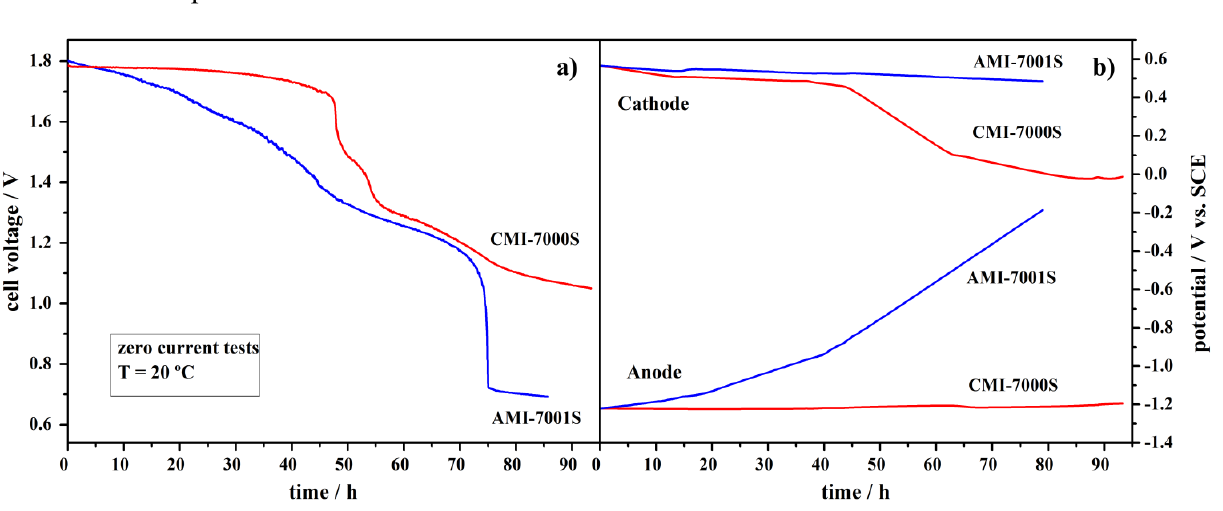
Figure 6. Durability tests for DBPFCs employing AMI-7001S and CMI-7000S membrane separators, at zero current flow, with ( a ) the cell voltage decay and ( b ) the corresponding electrodes’